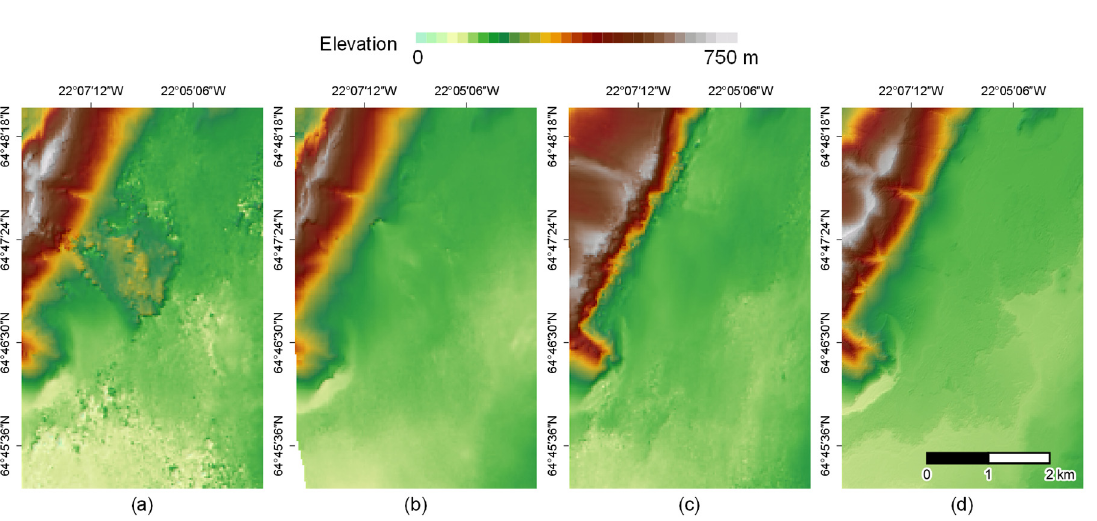
Figure 7. Illustration of the three post-event DEMs derived from the Sentinel-1 image pairs. ( a ) for orbit track number 16 (11 July 2018 and 17 July 2018), ascending; ( b ) orbit track number 118 (5 August 2018 and 11 August 2018), ascending; ( c ) orbit track number 155 (4 July 2019 and 10 July 219), descending; ( d ) ArcticDEM. For visualization purposes, each DEM is overlaid with the hillshade derived from it.